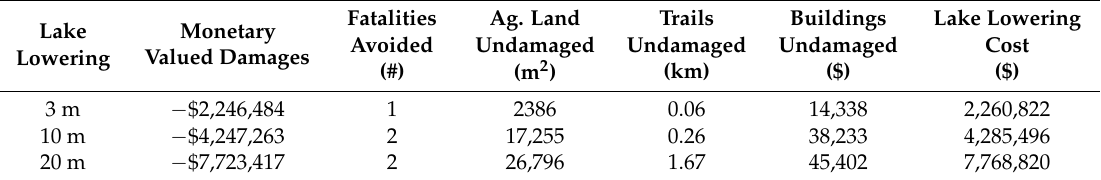
Table 8. Expected damage values relative to the BAU case with discounting over 7.5 years (event occurrence uniformly distributed over 15 years).